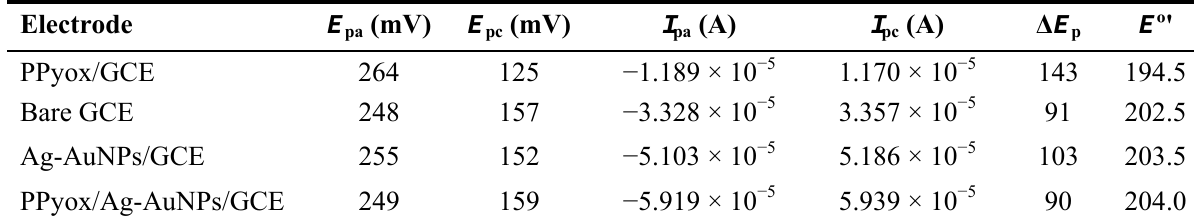
Table 1. CV data obtained from Figure